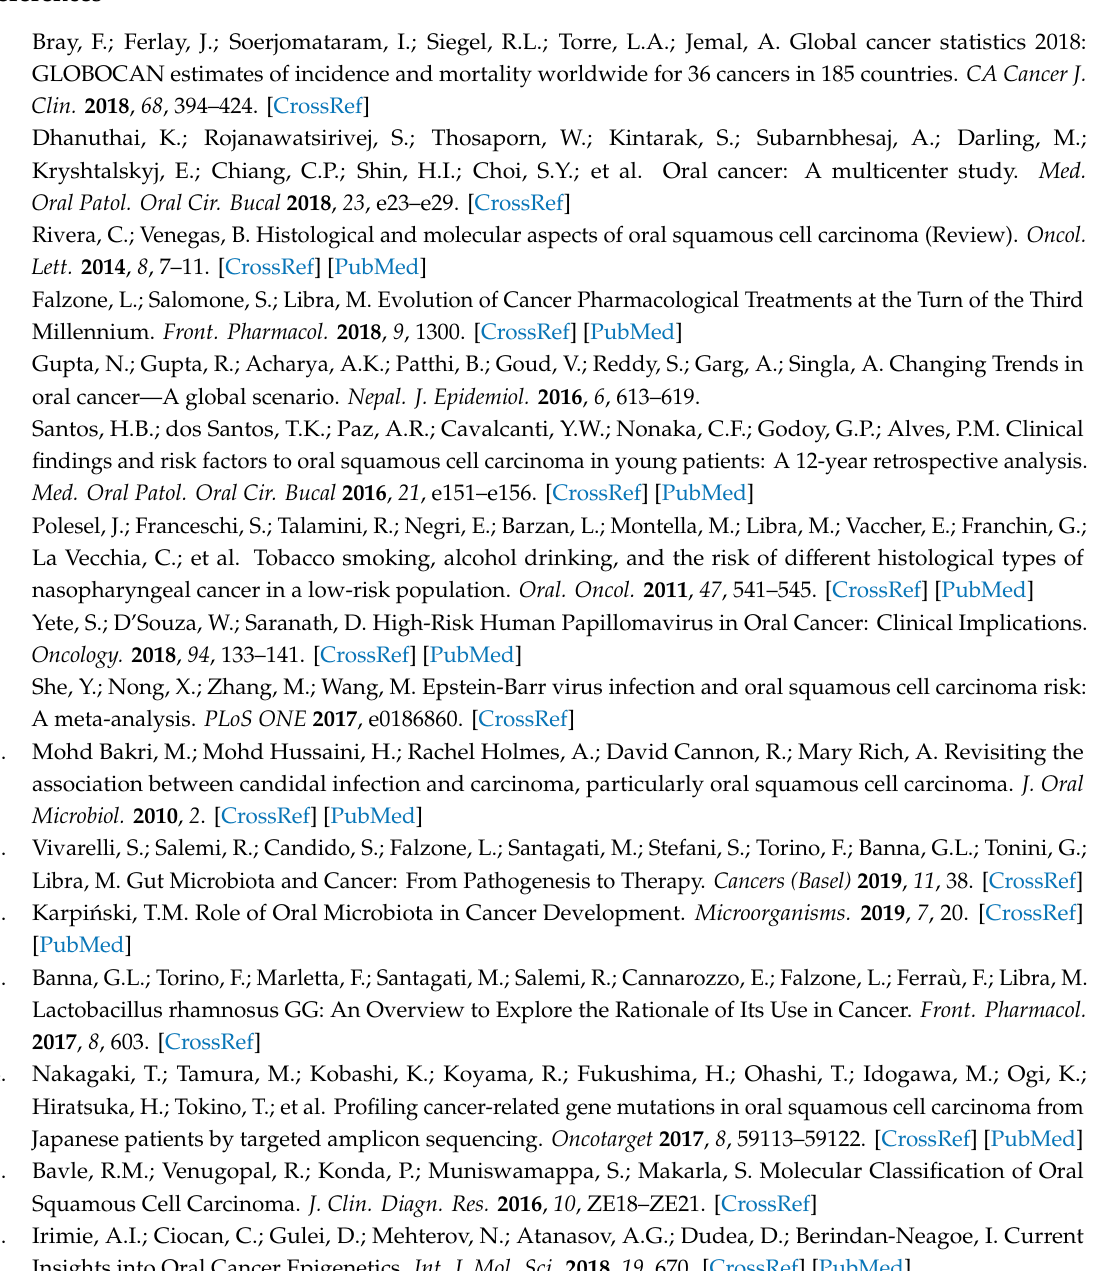
Table S1: List of 514 de-regulated TCGA HNSC miRNAs associated with the presence of tumor; Table S2: mirDIP number of prediction source and interaction levels between the 11 oral cancer-associated miRNAs and the genes identified by using COSMIC; Table S3: TCGA HNSC gene expression values of the 10 miRNA interacting genes. Author Contributions: Conceptualization, L.F., M.L. and S.C.; Formal analysis, G.R.M.L.R.; Investigation, L.F. and G.R.M.L.R.; Supervision, E.R. and M.L.; Writing – original draft, L.F.; Writing—review & editing, G.L.,